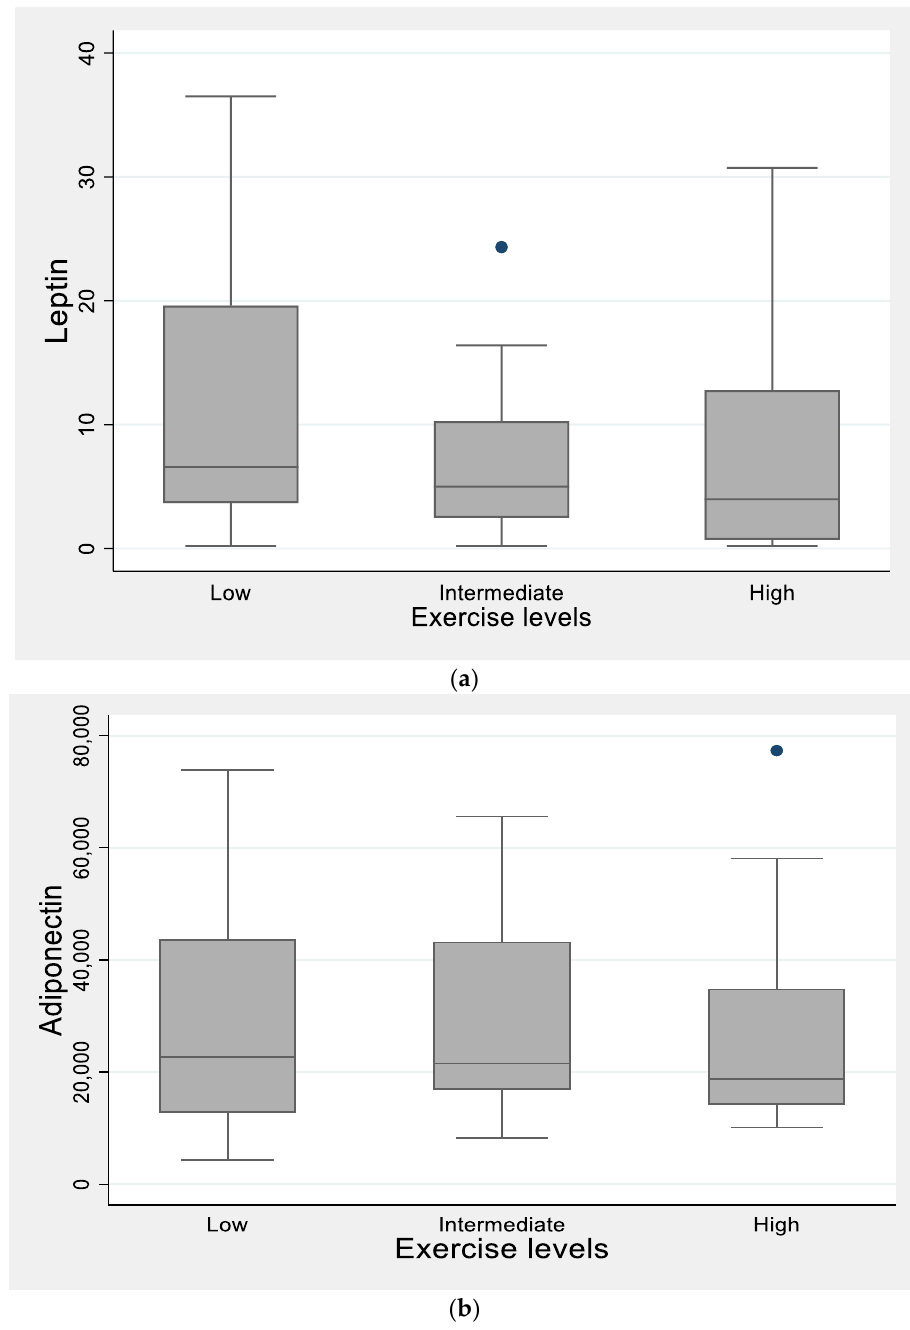
Figure 2. ( a ). Leptin levels were progressively increased inversely to the level of exercise, with the lowest levels in the high exercise group. ( b ). The three exercise groups were not significantly different in terms of adiponectin levels.